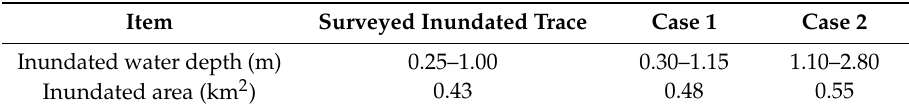
Table 4. Comparison of the inundated water depths and areas for Cases 1 and 2 with the surveyed inundated trace.